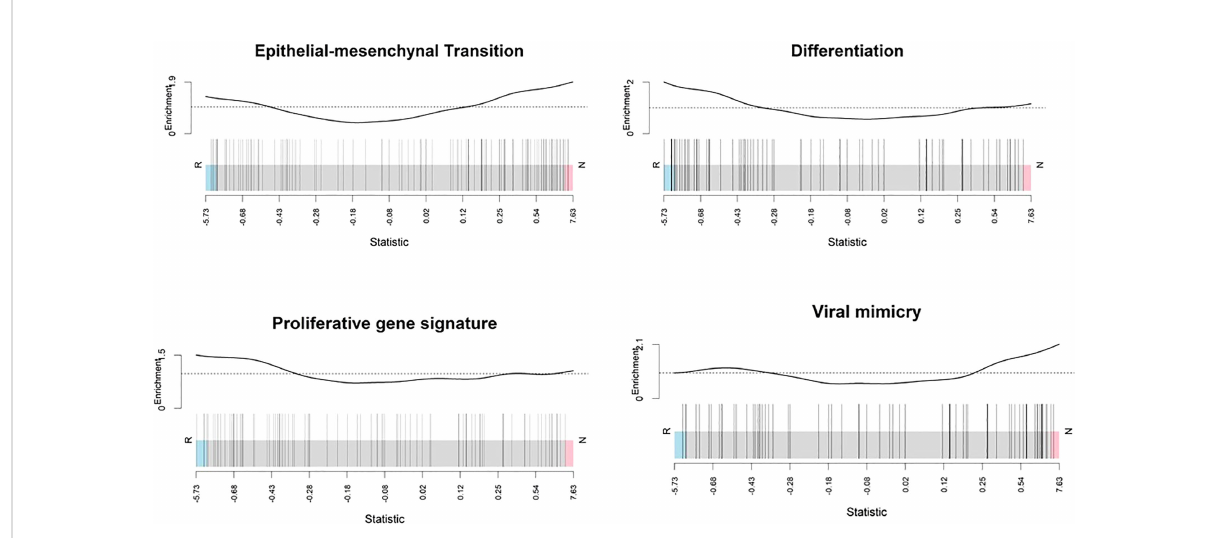
FIGURE 8 Enrichment score analysis. Barcode plots show that genes involved in the epithelial mesenchymal transition and viral mimicry detection were upregulated in non-responders whereas differentiation-associated genes and proliferative signature genes were downregulated. Genes expressed in the pro fi le datasets were ranked by log2 fold changes (high-expression/low-expression) in the responders (left side, n = 10) and non-responders (right side, n = 10). Overall shifts in the genes (represented by vertical bars) towards the left or right give an indication of the overall gene level for speci fi c pathways rather than at the individual gene level. Above each barcode plot enrichment scores are shown. Positive and negative values for enrichment scores mean positive and negative enrichment, respectively. Here, R, responder; N,